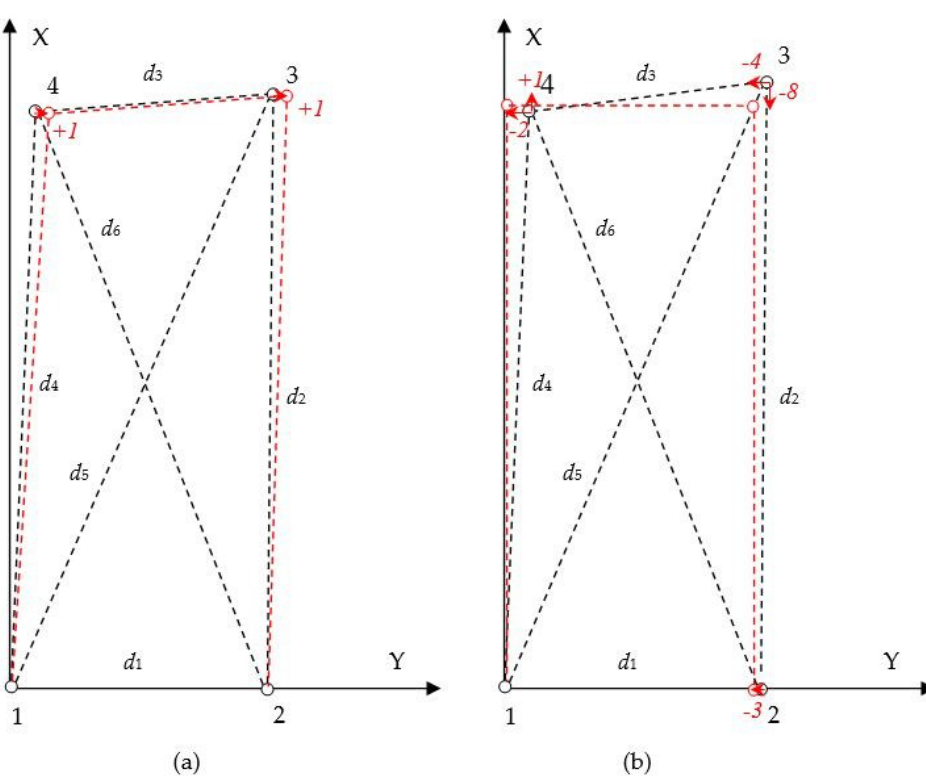
Figure 3. Deviations of coordinates obtained from the measurement from their adjusted values for variants 1 and 2 ( a ) and variant 3 ( b ).